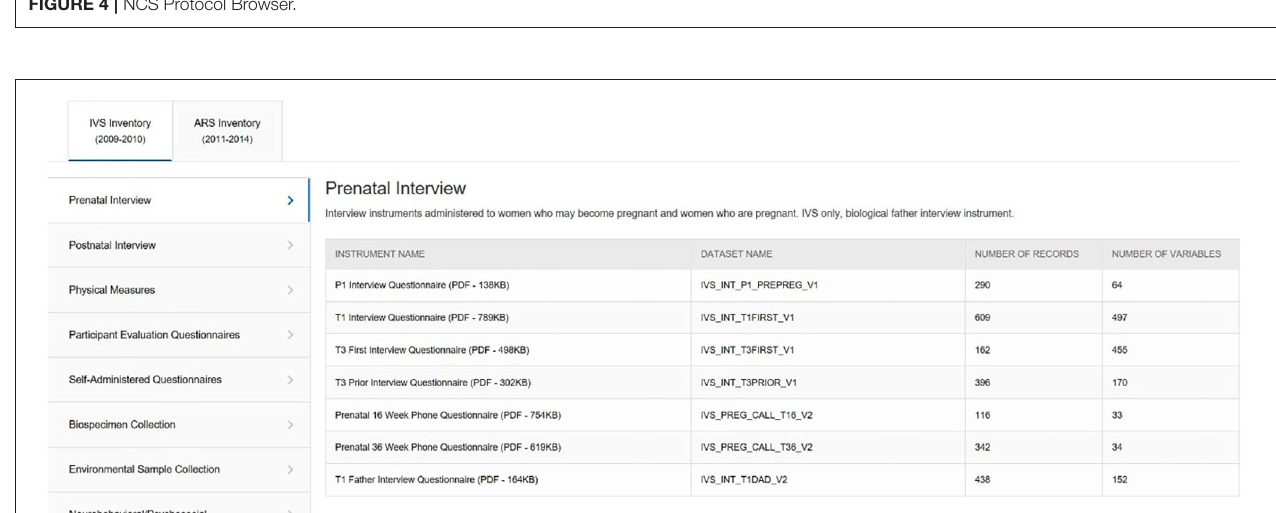
FIGURE 4 | NCS Protocol Browser.